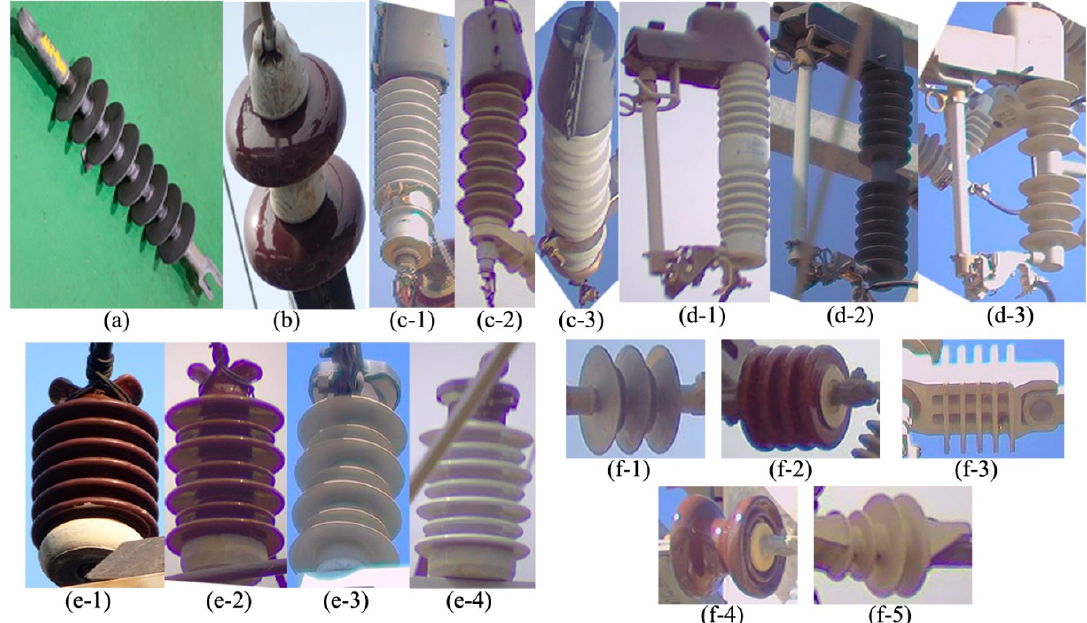
Figure 1. Example images of various types of electrical equipment that can be detected by our proposed system. Insulators of ( a ) polymer and ( b ) porcelain; Lightning-Arrester (LA) of ( c-1 ) porcelain with uniform cap sizes, ( c-2 ) polymer, ( c-3 ) porcelain with non-uniform cap sizes; Cut-out-Switches (COS) of ( d-1 ) porcelain, ( d-2 ) polymer with uniform cap sizes, ( d-3 ) polymer with non-uniform cap sizes; Line-Post (LP) of ( e-1 ) porcelain with uniform cap sizes, ( e-2 ) porcelain with non-uniform cap sizes, ( e-3 ) polymer, ( e-4 ) porcelain of white color; and COS or LA’s add-ons of ( f-1 ) polymer, ( f-2 ) porcelain with four caps, ( f-3 ) square shaped, ( f-4 ) porcelain with two caps and ( f-5 ) polymer with two caps. For training CNN, we grouped the equipment into 6 base classes, i.e., ( a ) polymer insulator, ( b ) porcelain insulator, ( c ) LA, ( d ) COS, ( e ) LP, and ( f ) add-on.